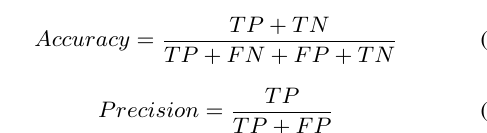
Table 2: Resulting classification accuracy and precision rates after the application of different deep architectures in the SAT-6 dataset. measures have been calculated.